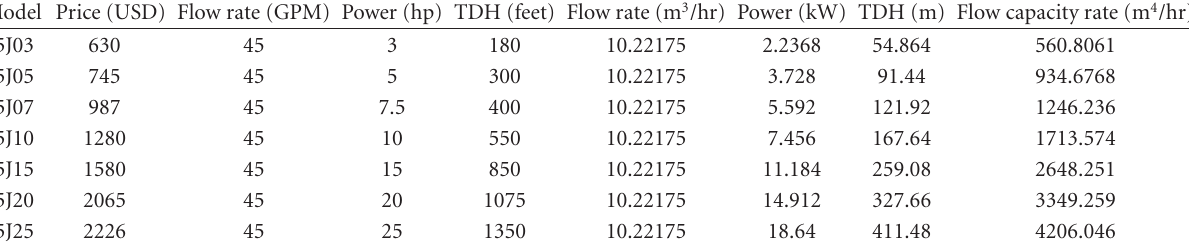
(a) Specifications of Goulds water pumps 45J series considered